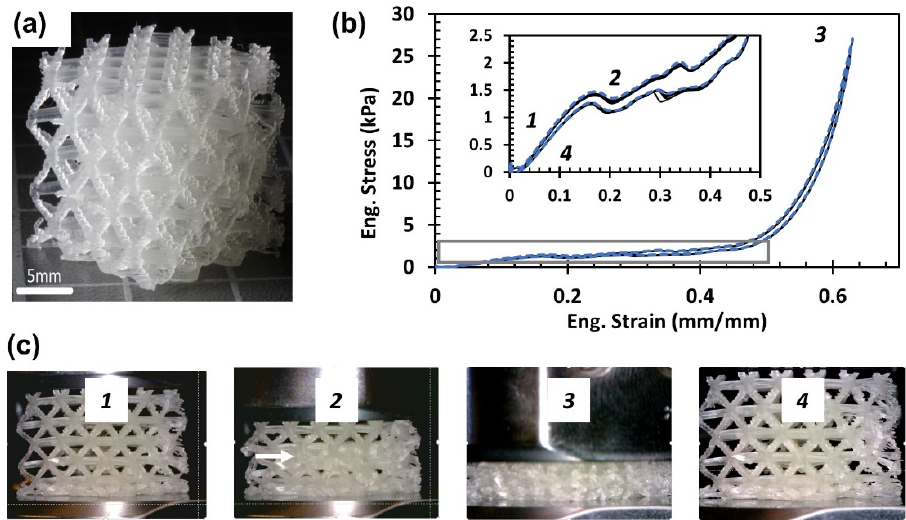
Figure 5. Octet truss lattice compressed to 33% strain. ( a ) Picture of undeformed lattice. ( b ) Stress vs. strain plot for compression up to 67% strain, with a highlighted region between 0% and 45% strain that shows two regions of negative stiffness. Blue dotted line represents the first compression cycle followed by an additional nine cycles (thin black lines). Numbers correspond to the pictures in 5c. ( c ) Pictures of lattice structure under compression during stages (1)–(3) and relaxed at (4). At 20% strain, one layer of unit cells has collapsed (arrow in picture 2), exhibiting negative stiffness behavior.